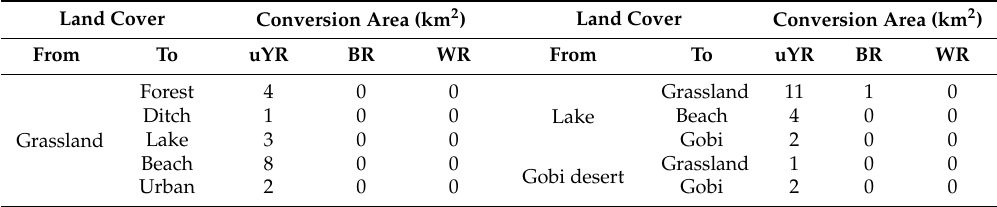
Table 5. The area statistics of land use and cover change in the study area from 1985 to 2005 indicated by the satellite-based Land Use and Land Cover Dataset of China (km 2 ). Most of the land use and cover changes occurred in upstream areas of the uYR basin, with only 3 km 2 and 2 km 2 of land cover conversion occurring in the BR and WR basins,